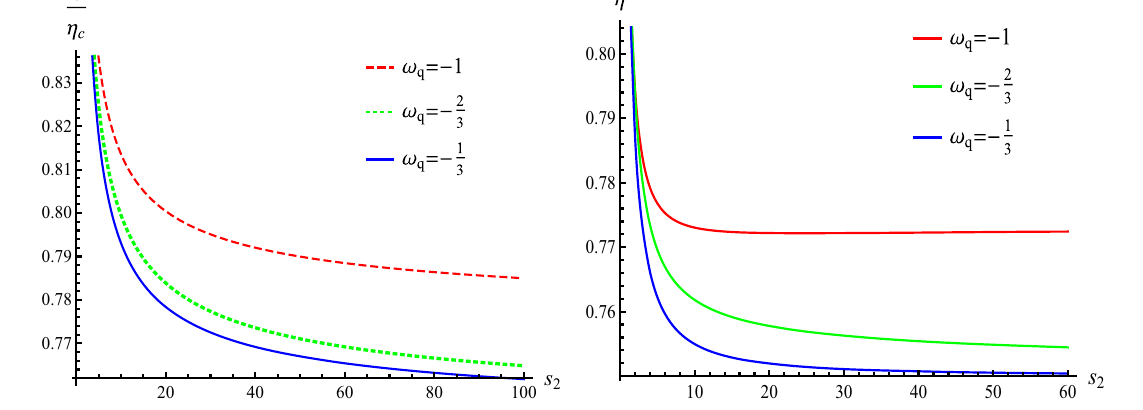
Fig. 5 The two figures above are plotted at three different fixed state parameters ω q , here we take P 1 = 4 , P 4 = 1 , S 1 = 1 , Q = 1 and normalization factor a = 1. The left figure corresponds to the ratio between the efficiencies η and η c , the right one to efficiency